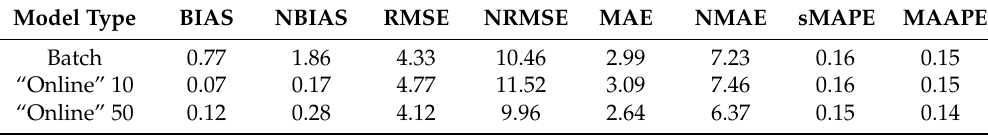
Table 5. One-hour ahead forecasting error evaluation for the different used types of RF. BIAS, RMSE and MAE are in the same units as the electricity price (c € /kWh); NBIAS, NRMSE, NMAE, sMAPE and MAAPE are in percentage.